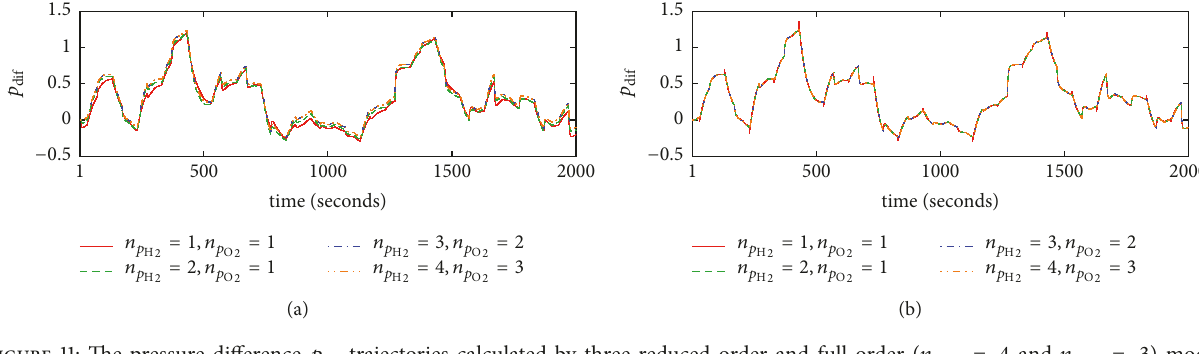
Figure 11: The pressure difference 𝑝 dif trajectories calculated by three reduced-order and full-order ( 𝑛 𝑝 determined by algorithm 1 (a) and algorithm 2